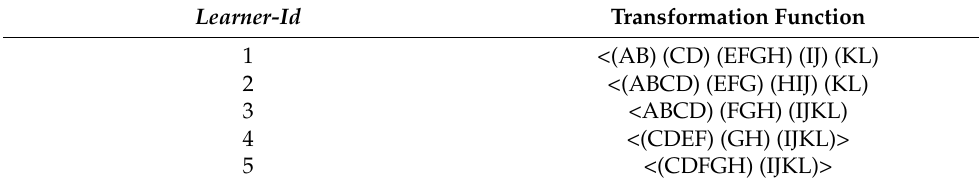
Table 5. Transformation Function based on Learner-Id .